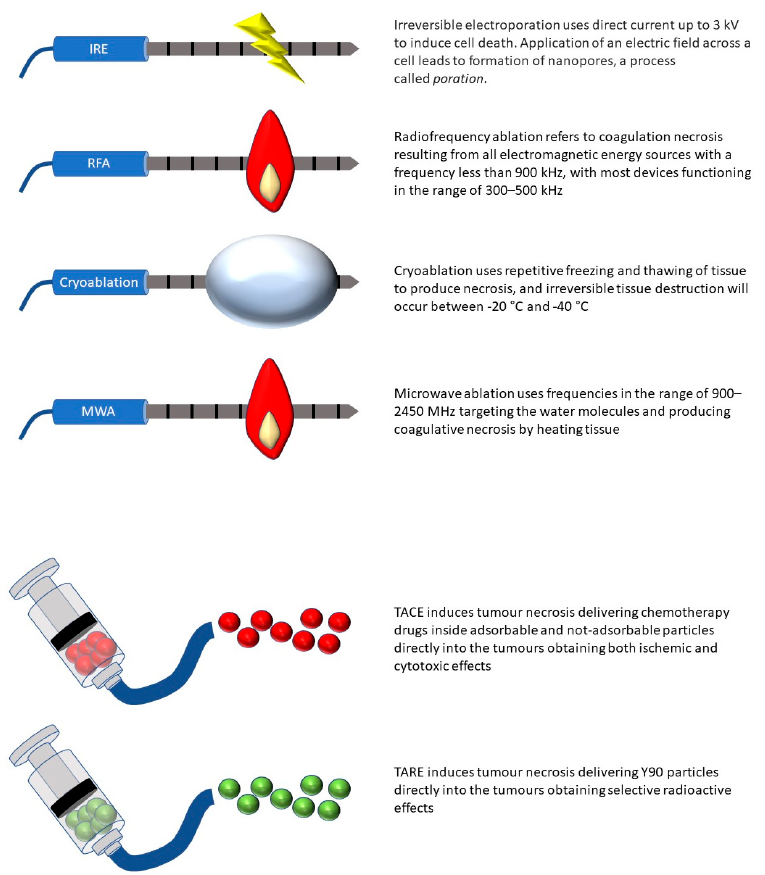
Figure 1. Interventional oncology ablative and endovascular techniques and mode of action. IRE: irreversible electroporation; RFA: radiofrequency ablation; MWA: microwave ablation; TACE: transcatheter arterial chemoembolization; TARE: transcatheter arterial radioembolization.